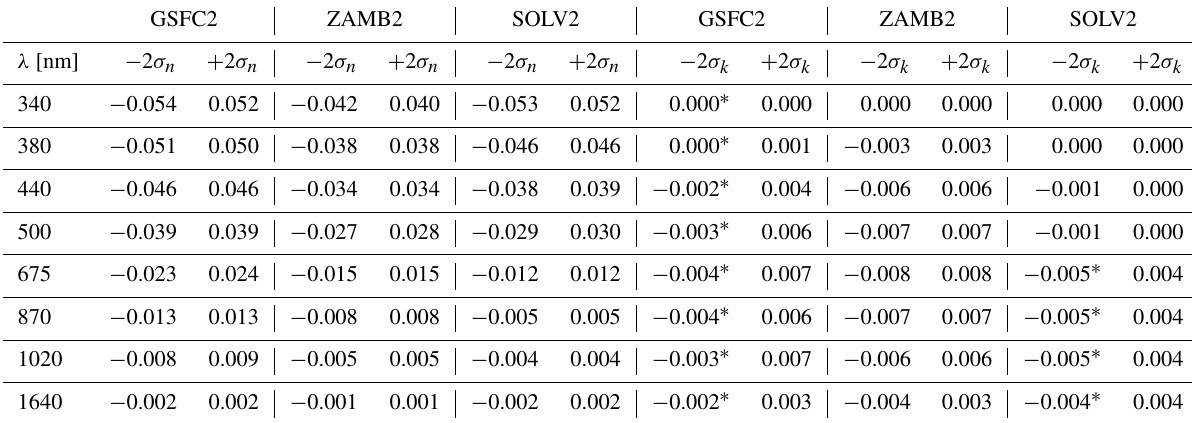
Table 10. Change in the aerosol optical depth (references in Table 2) caused by changes of ± 2 σ in the complex refractive index ( n,k ) for GSFC2, SOLV2 and ZAMB2 (reference values in Table 1). The value of 2 σ n is equal to 0.02 for GSFC and ZAMB, while it is equal to 0.06 for SOLV. For the imaginary part, 2 σ k has values of 0.008, 0.006 and 0.002 for ZAMB, GSFC and SOLV respectively. Note that k − 2 σ k can be negative at some wavelengths; for those cases, k is fixed as zero and is indicated by an asterisk in the